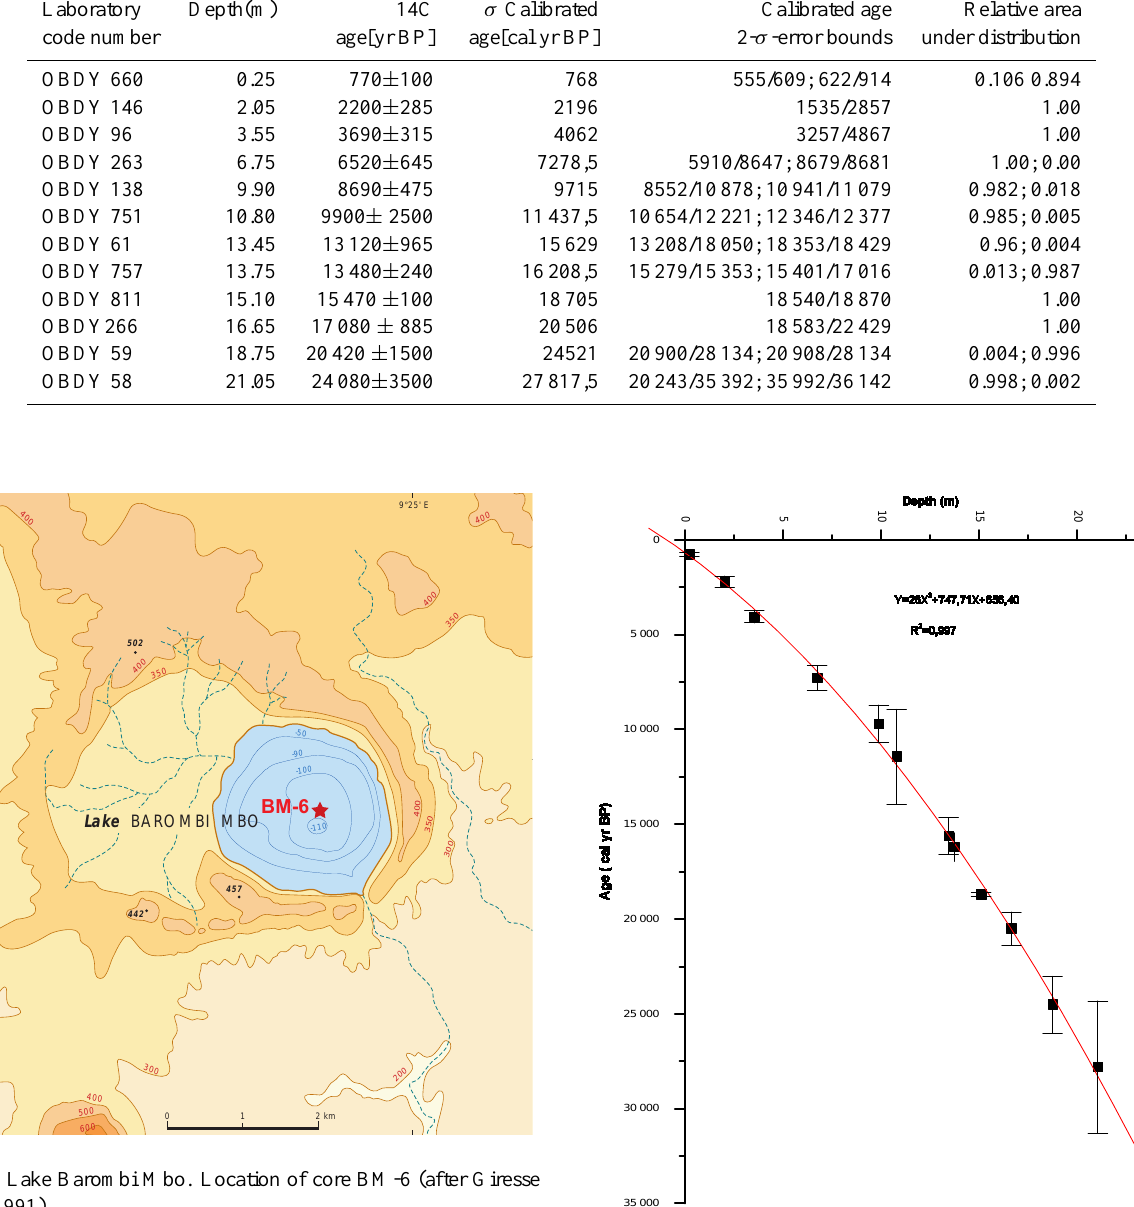
timate P ann and temperature in East Africa (Bonnefille et